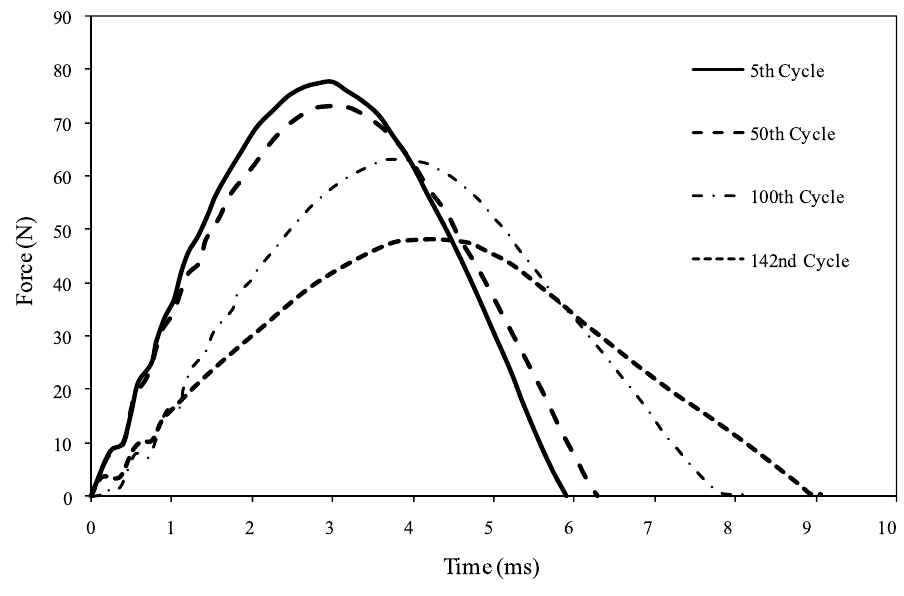
Fig. 3. Effect of repeated impacts at a constant impact energy on the force-time